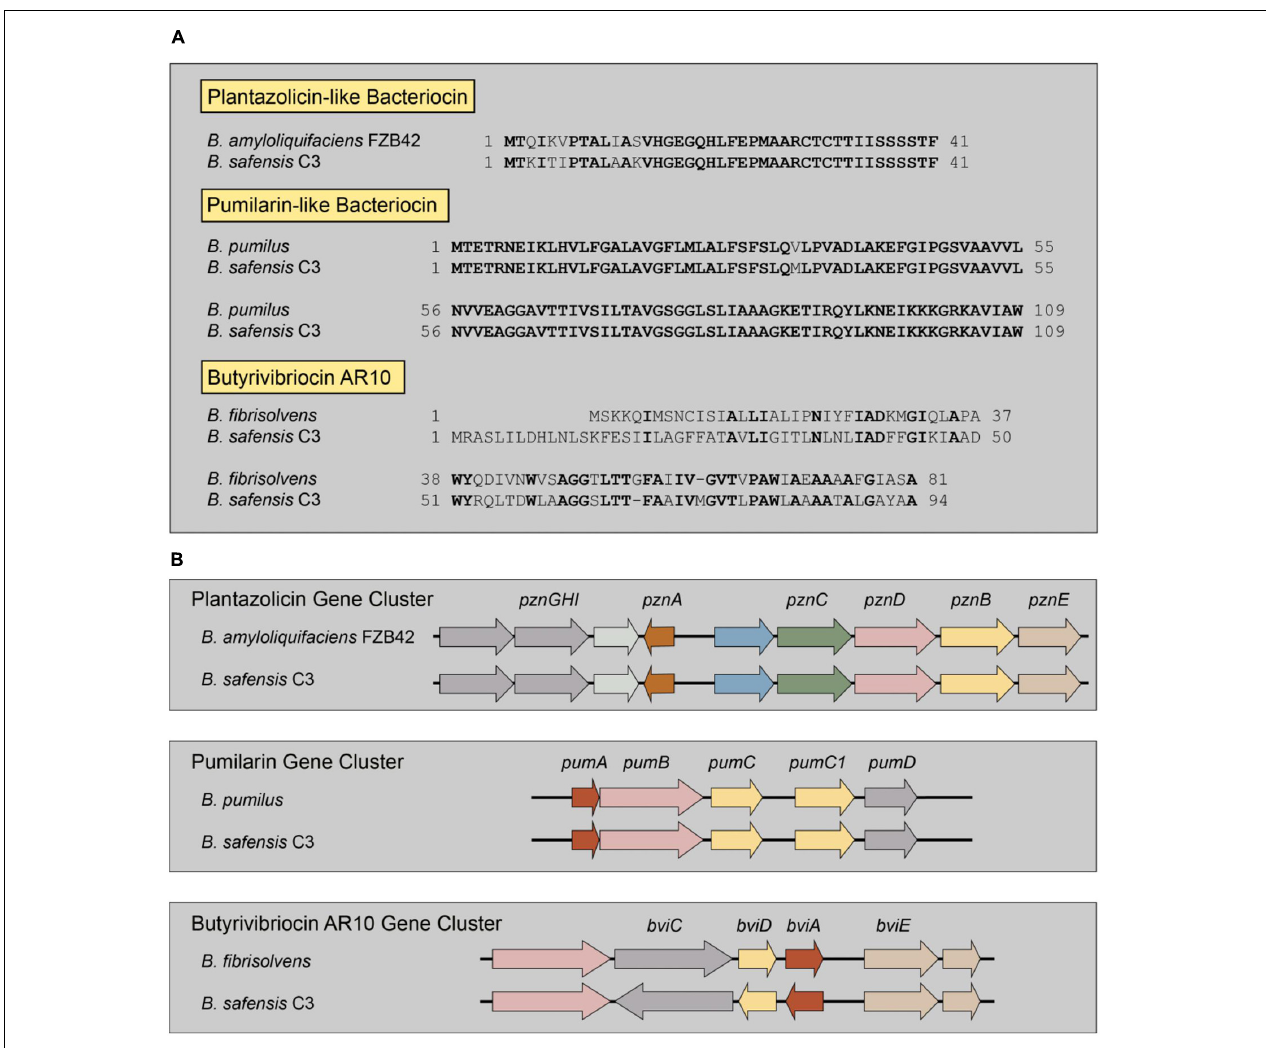
FIGURE 3 | Identification of multiple bacteriocin genes present in the genome of C3. (A) Comparison of the amino acid sequences of known bacteriocins to those identified in the genome of C3. Residues in bold indicate identical amino acids. Butyrivibriocin AR10 from Butyrivibrium fibrisolvens and C3 possess highly similar C-terminal regions denoted by a double-glycine cleavage site (red italics). Clustal-based protein alignments are provided in supplement ( Supplementary Figures 3 , 4 ). (B) Presence and organization of bacteriocin biosynthetic gene clusters in the genome of